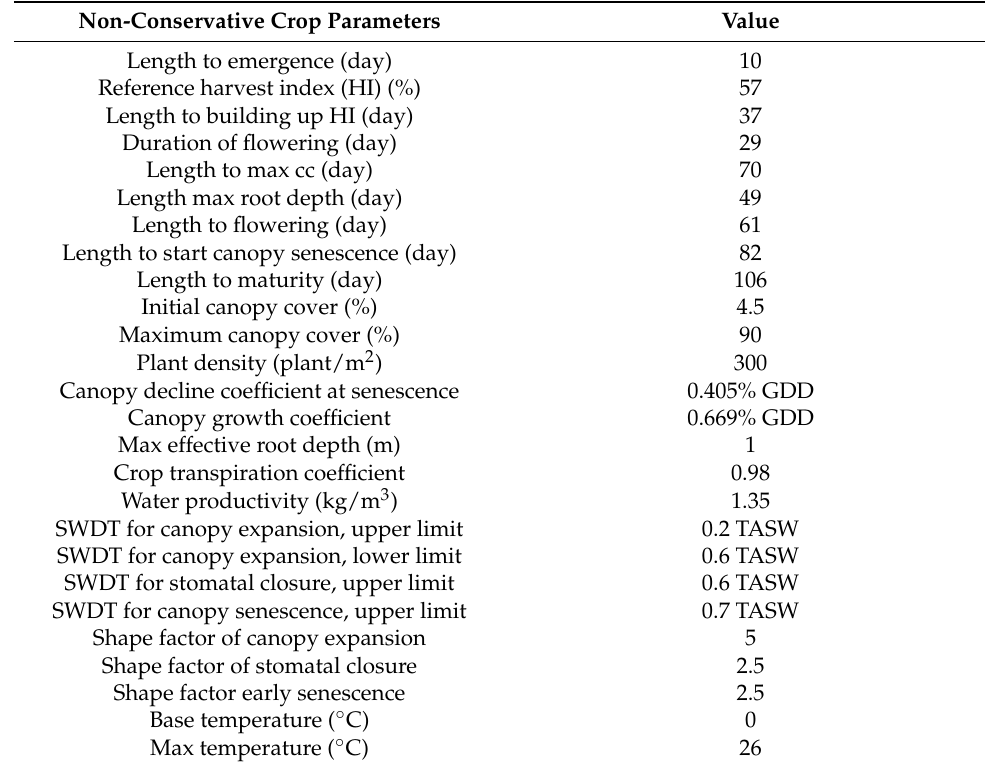
Table 2. Calibrated AquaCrop model specific parameters for Mexicali cultivar of wheat. Non-Conservative Crop